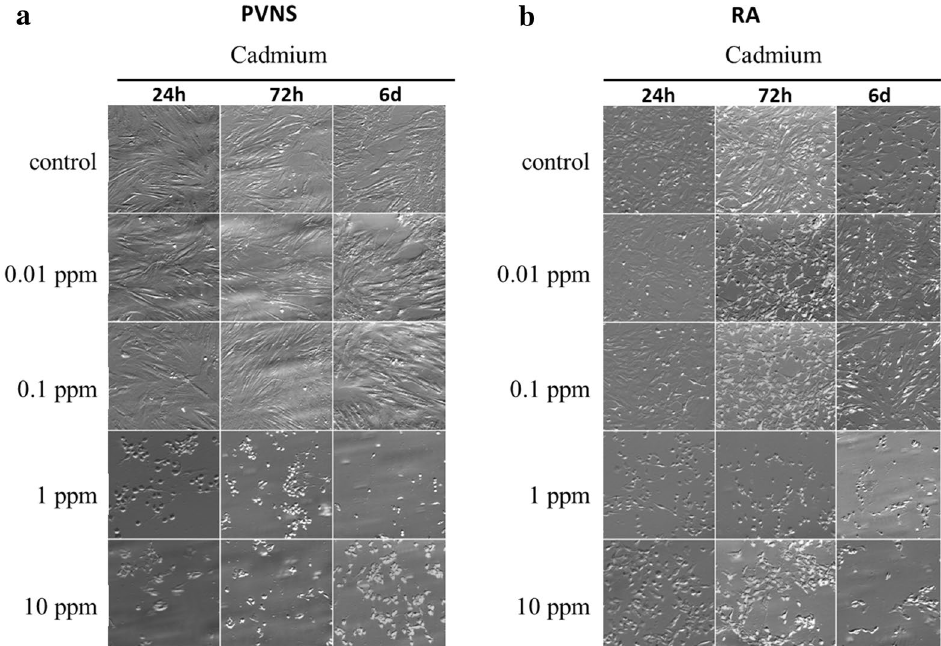
Figure 1. Observation of cell death by light microscopy. PVNS ( a ) and RA ( b ) synoviocytes, used between passages 4 to 9, were treated with HNO 3 as the control or with increasing concentrations of Cd (0.01